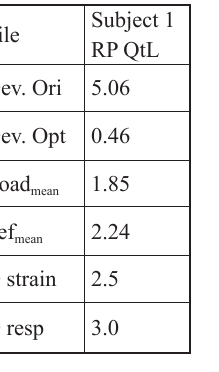
Note. RP: Right-arm push-up; QtL: Quantitative Load; Pef: performance; dev.ori: original deviation of data; dev.opt: deviation of optimized data; D strain: delay of strain; D resp: de- lay of response.